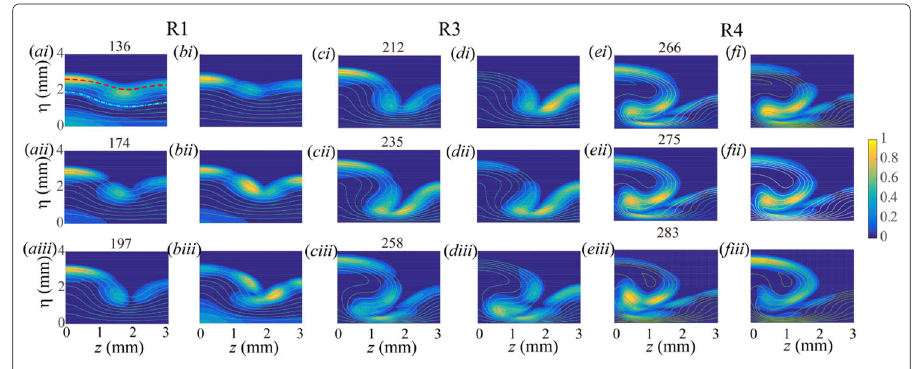
Fig. 4 Normalized mode shapes (temperature eigenfunctions) variations during mode synchronization: ( a ) mode V1 and ( b ) mode V2 in region R1, ( c ) mode V1 and ( d ) mode V3 in region R3, and ( e ) mode V1 and mode V2 in region R4. The Roman numbers denote the locations upstream from, right in and downstream from the synchronization point. The streamwise locations (mm) are indicated in the title of the figures